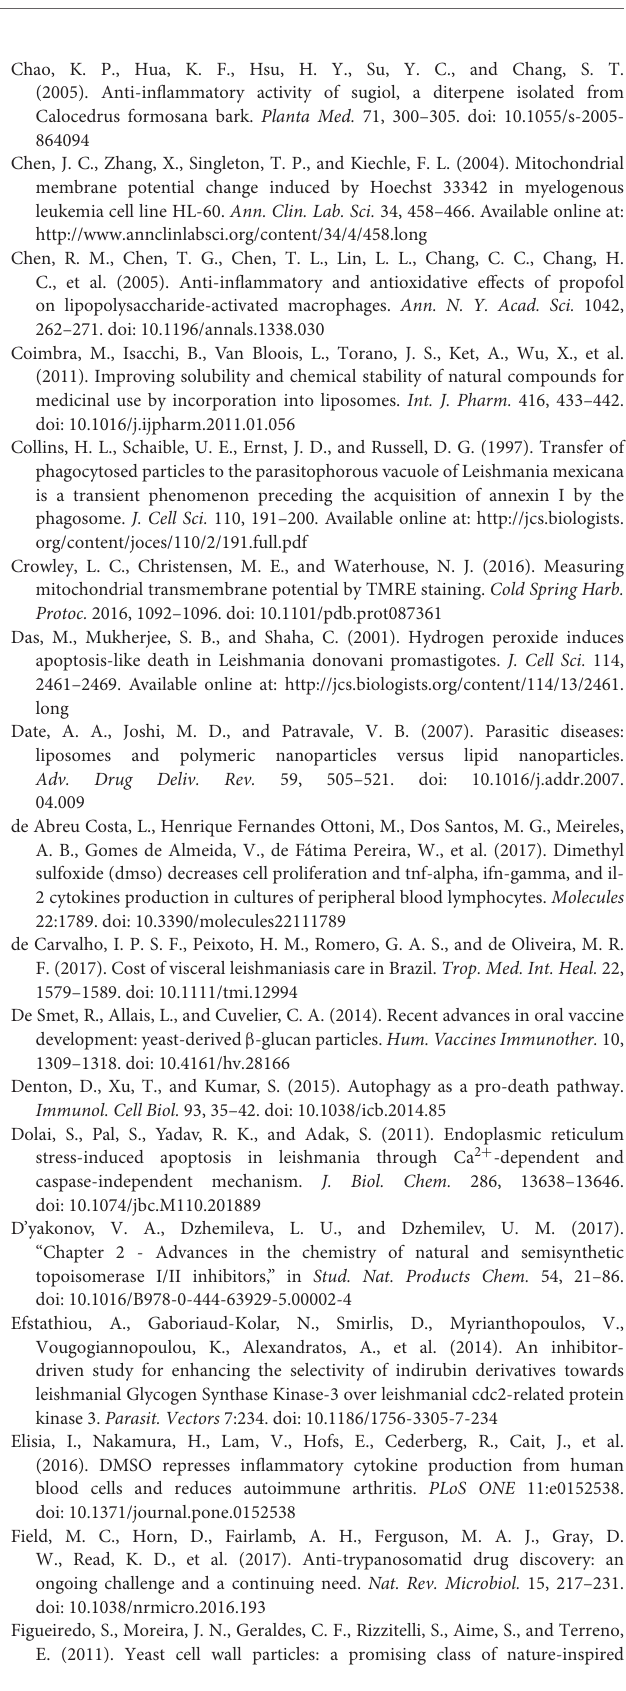
Frontiers in Cellular and Infection Microbiology |